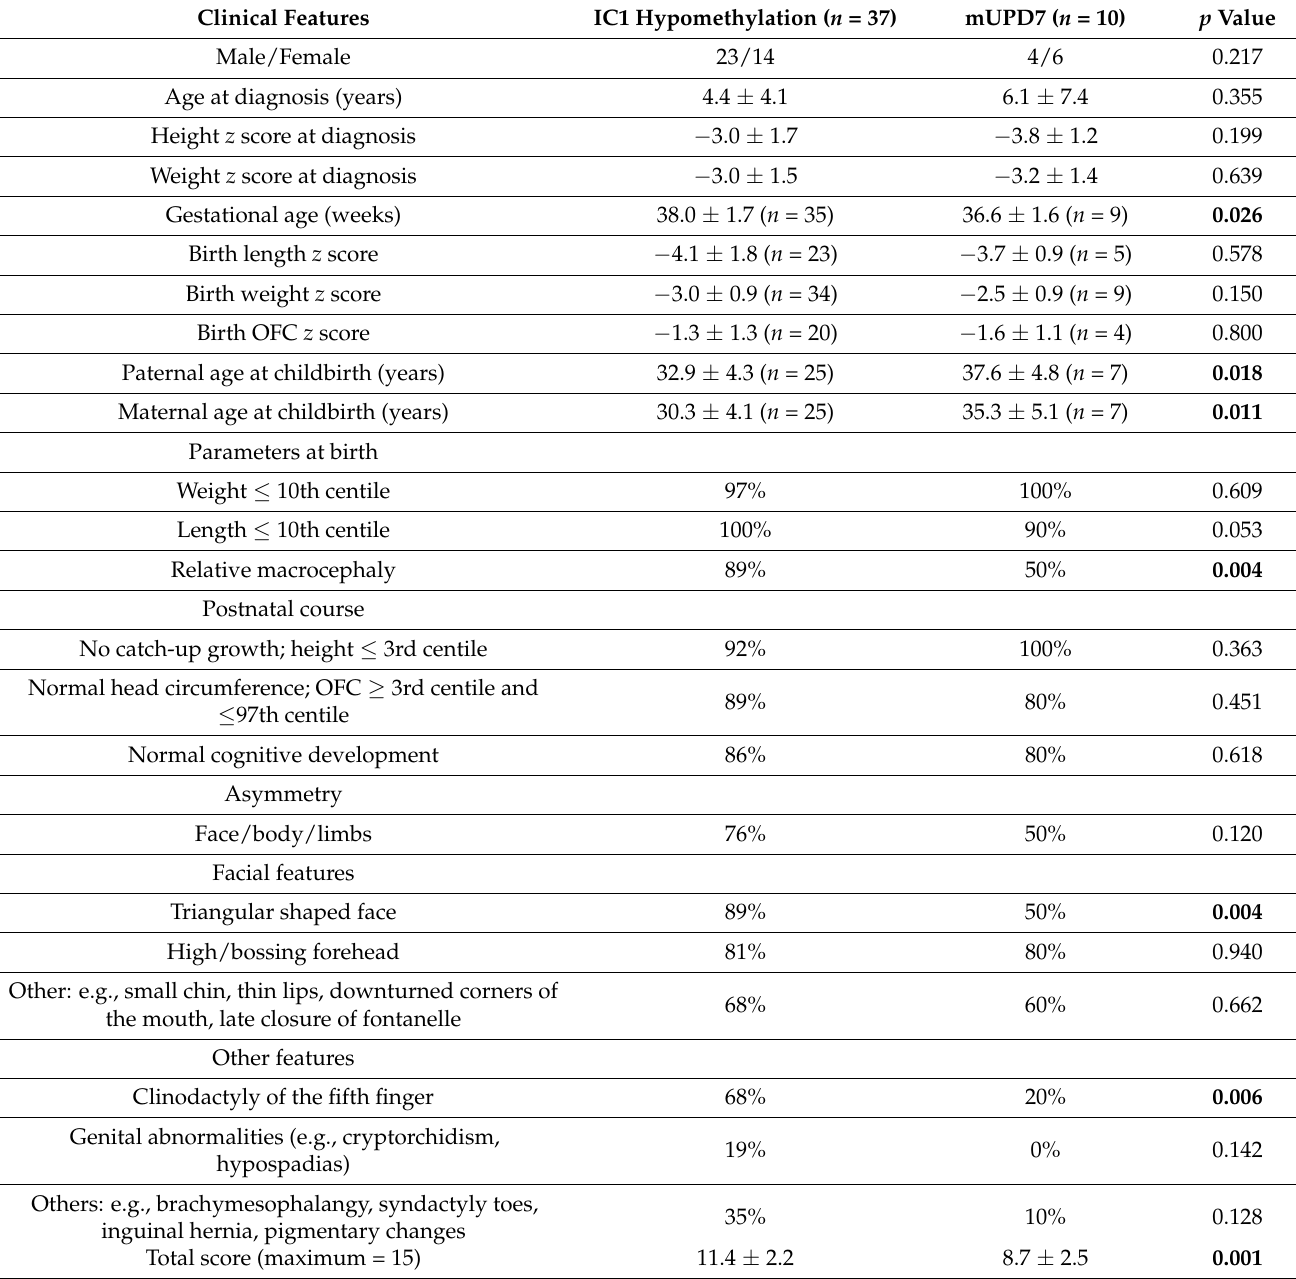
Table 4. Clinical features of 37 SRS subjects with IC1 hypomethylation and 10 SRS subjects with mUPD7. Clinical